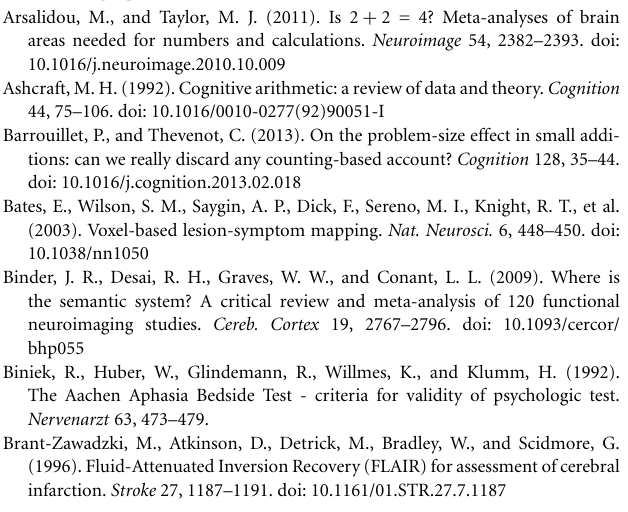
Supplementary Table 1 | Demographic and clinical data of all